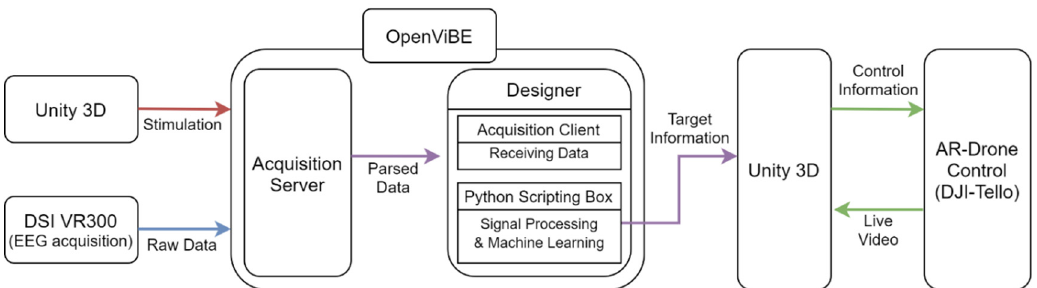
Figure 1. The structure of the drone control system overall.